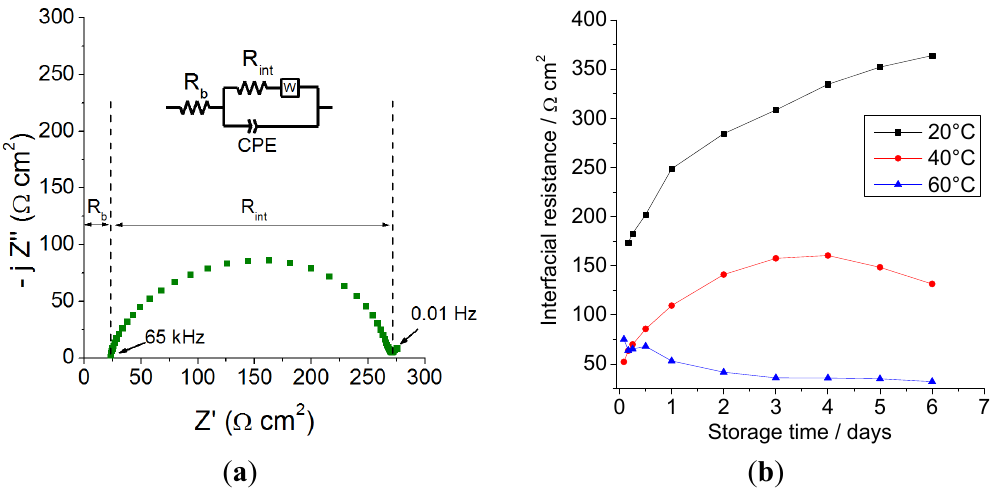
Figure 2. ( a ) Sample Nyquist plot of a Li/0.1 LiTFSI-0.9 Pyr ( b ) evolution of the interfacial resistance of the cells at 20, 40 and 60